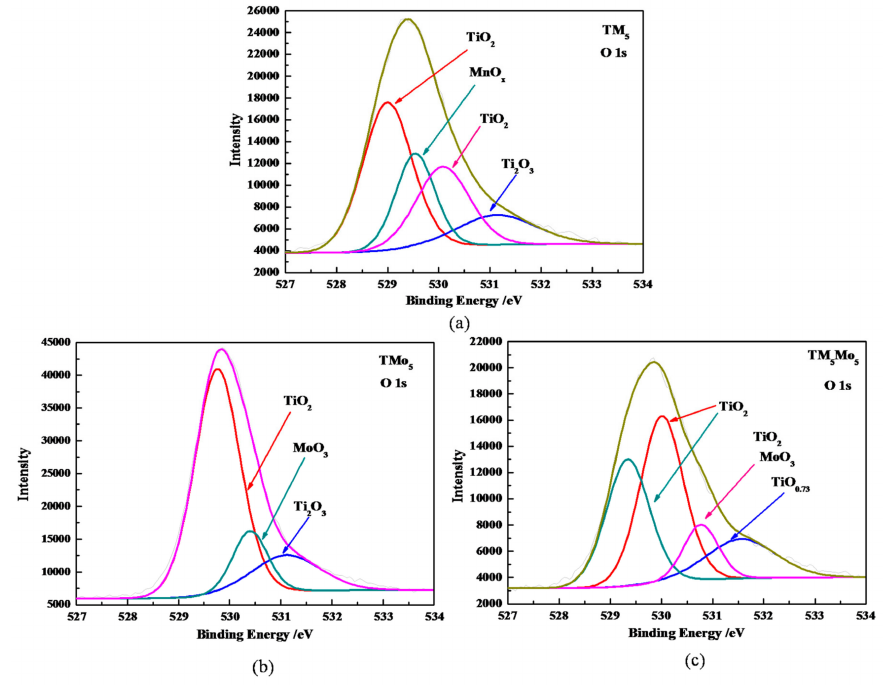
Figure 5. The XPS analysis of O 1 s for ( a ) TM 5 ; ( b ) TMo 5 and ( c ) TM 5 Mo